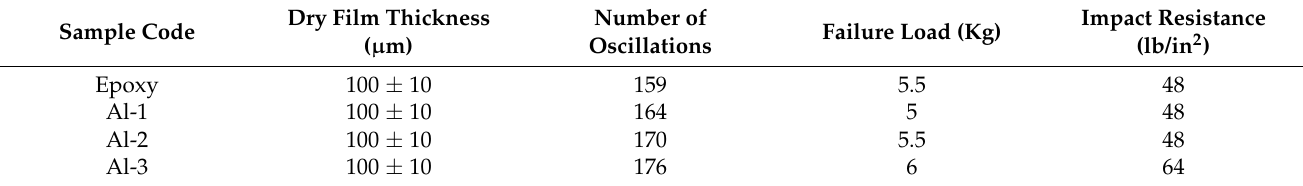
Table 3. Obtained results on the fabricated epoxy coatings containing different Al particles. Sample